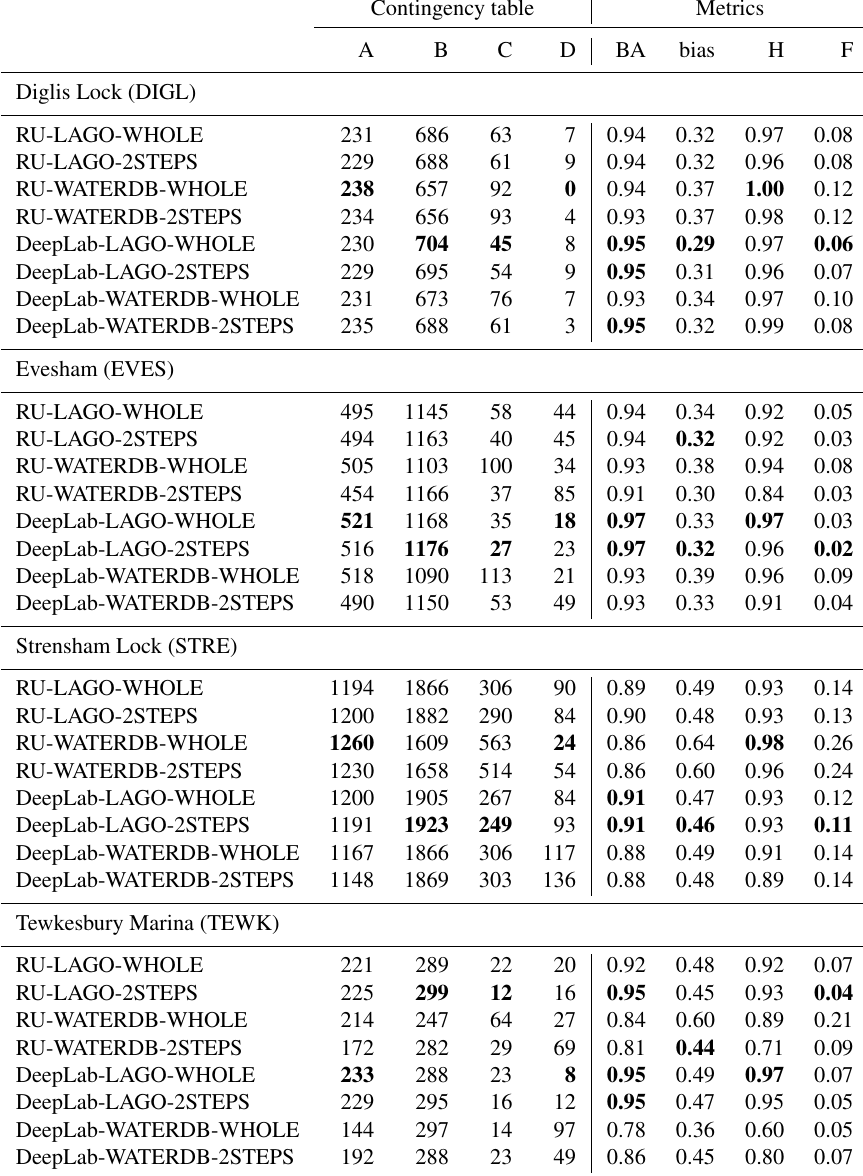
Table 4. Landmark detection results (for the metric meanings, see Table 3). For each location and each metric, the best network results are in bold. RU stands for the ResNet50-UperNet